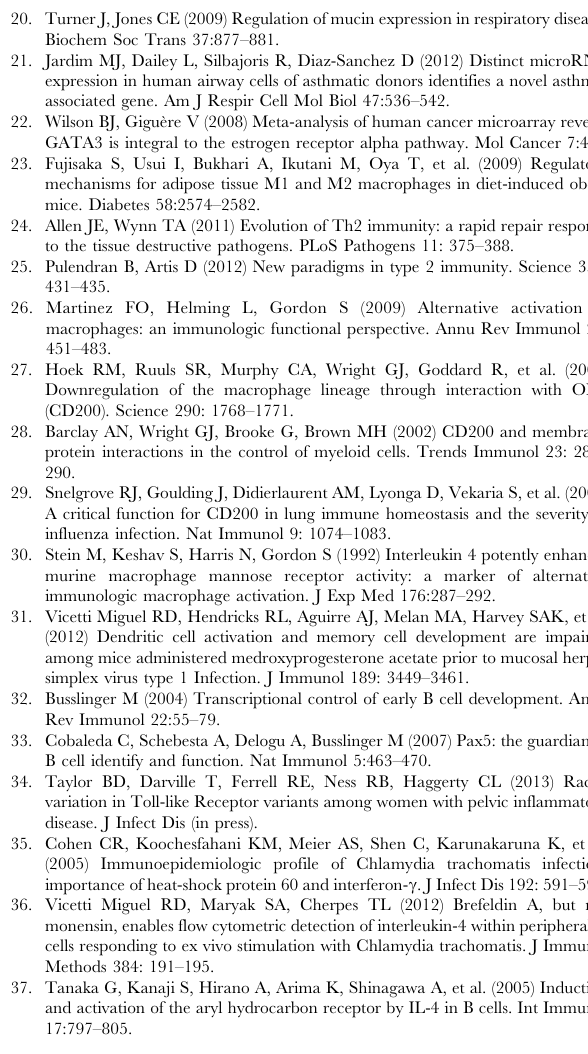
hoc test (horizontal bars indicate medians). Grey boxes indicate the pairs considered in the comparison for each indicated p value, and significant p values are indicated in bold characters. Figure S3 Gating strategy used to identify macrophages infiltrating endometrial tissue. Cryopreserved endometrial cells were processed for flow cytometric analysis as described in Methods section. Contour plots depict the gating strategy used to define macrophage populations within endometrial cell suspen- sions. Plots show in sequence the gating hierarchy used to interrogate for CD45 + , live non-CD15 + cells, singlets, and finally to define the macrophage population as CD14 + HLA-DR + (red gate). Representative contour plots displaying expression of some of the surface markers evaluated are also shown (red overlay indicates CD14 + HLA-DR +